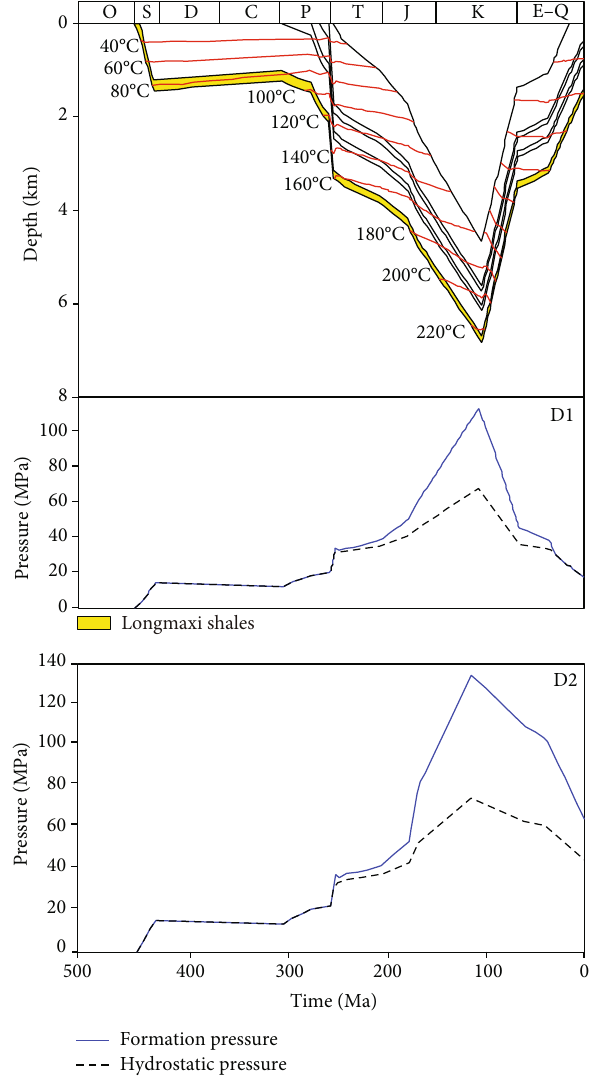
Figure 9: The “ burial-hydrocarbon generation-uplift ” evolutionary framework of wells D1 and D2 (according to Qiu et al. [53] modi fi ed) (O: Ordovician; S: Silurian; D: Devonian; C: Carboniferous; P: Permian; T: Triassic; J: Jurassic; K: Cretaceous; E: Paleogene; Q: